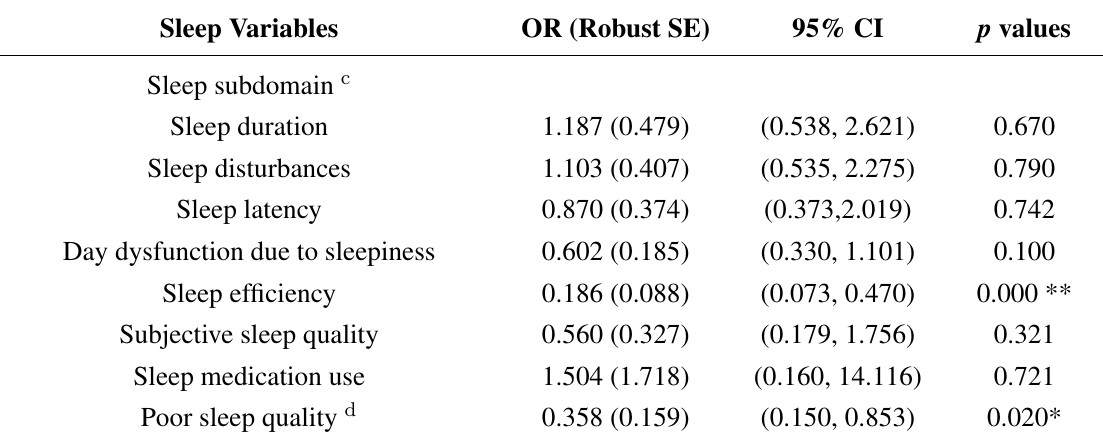
Table 4. Adjusted regression models a of sleep quality in adolescence on blood zinc concentrations in preschool b